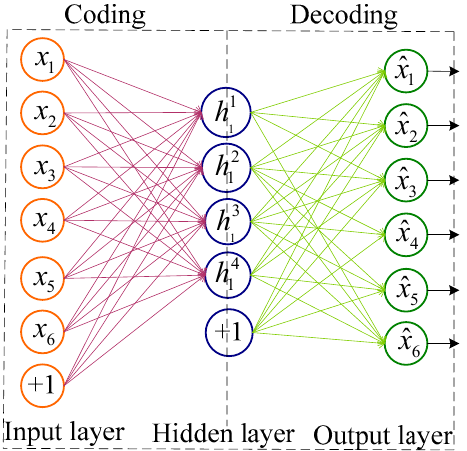
Figure 1. Autoencoder structure diagram.